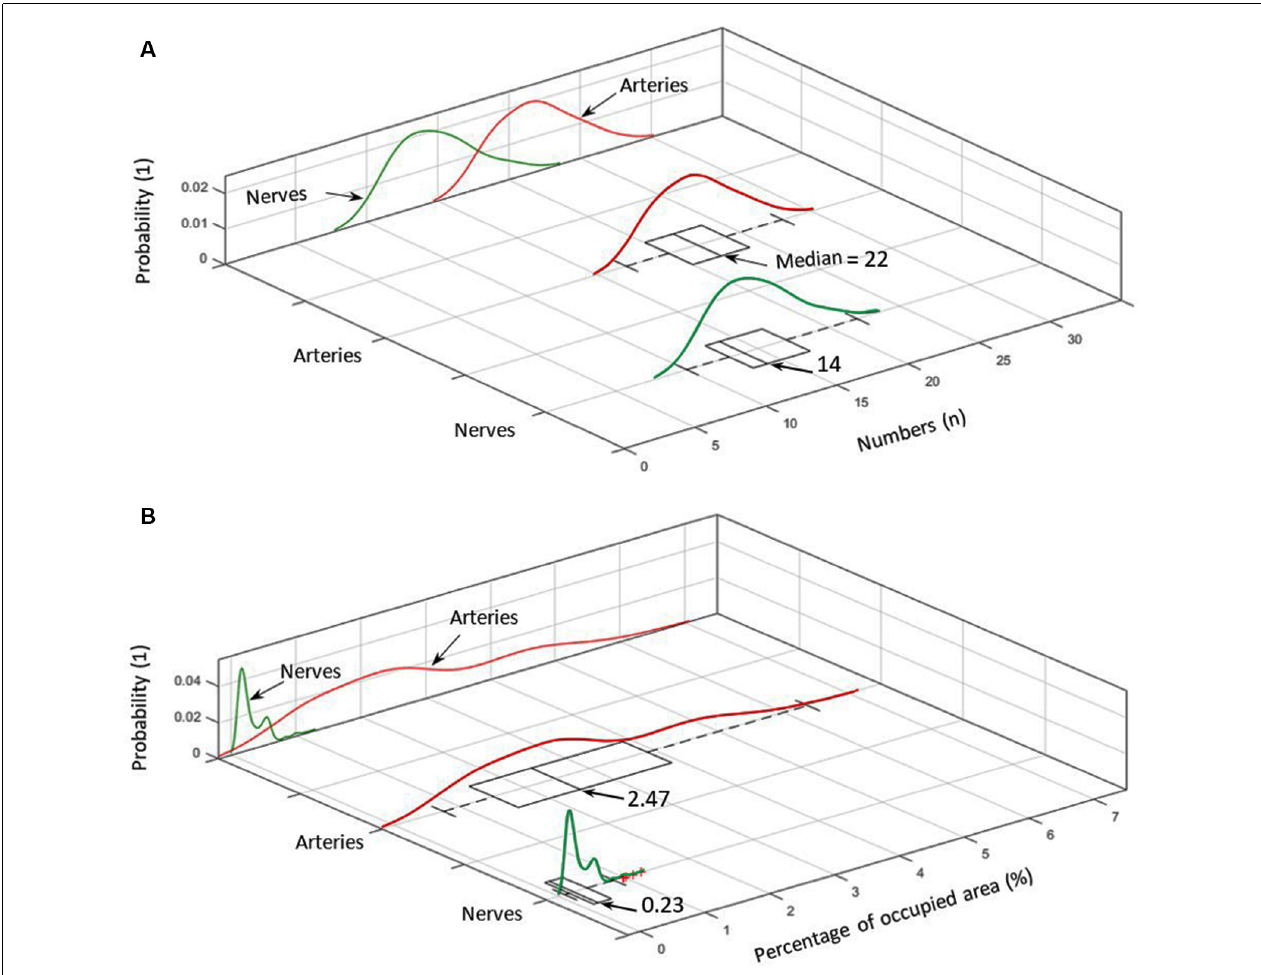
FIGURE 5 | (A) Number distribution of elements for arteries (red) and nerves (green) including the corresponding probability density within the analyzed cymba conchae (CC). (B) The probability density of the occupied area in percentage for nerves and arteries.